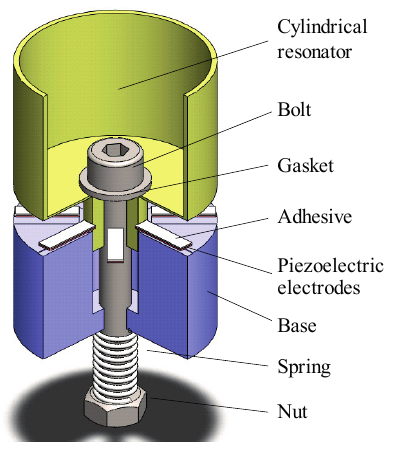
Figure 4. Schematic of the pasting of the piezoelectric electrodes.